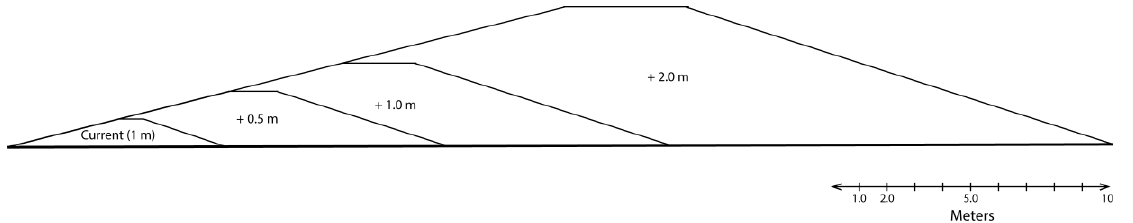
Figure 2. Cross-section of a levee depicted under different sea level rise scenarios.